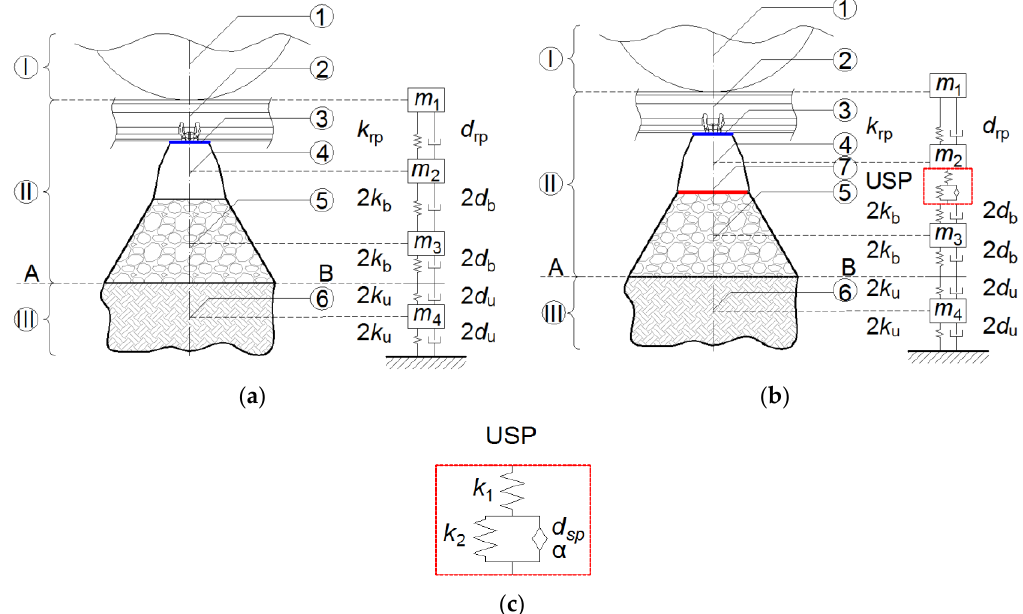
Figure 7. Rheological model of the ballasted track structure: ( a ) Reference model; ( b ) Model with USP; ( c ) Rheological model of USP. Symbols: A-B — subgrade surface layer; I — rolling stock, II — railway track structure, III — subgrade; 1 — non-spring part of the rolling stock, 2 — rail, 3 — rail pad, 4 — sleeper, 5 — ballast, 6 — subgrade, 7 — USP.